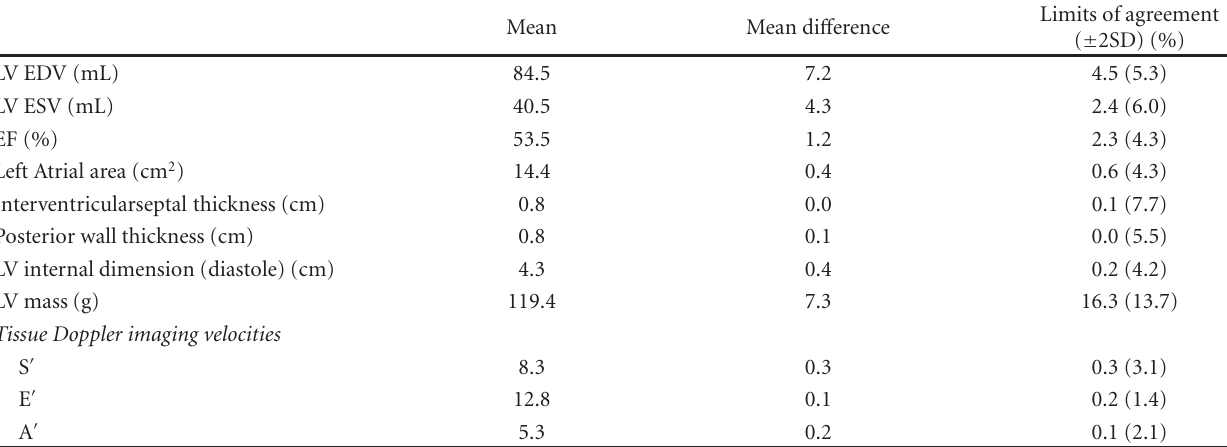
Table 4: Interobserver